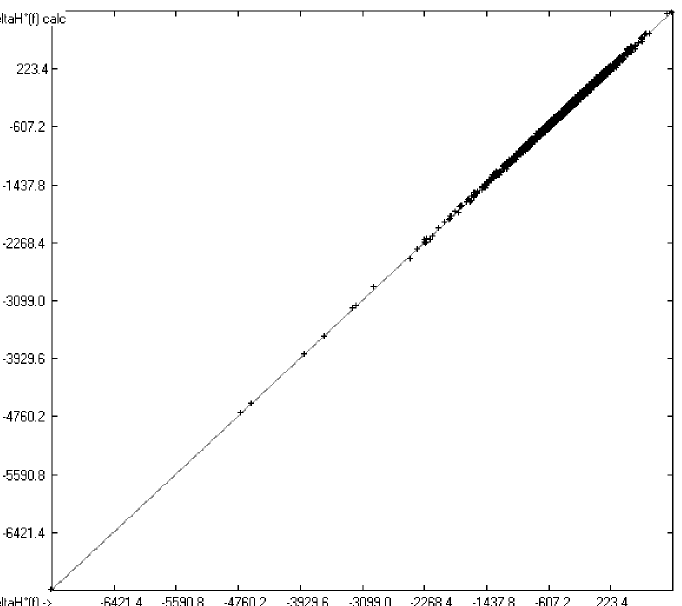
Figure 3. Correlation diagram of the heat of formation (in kJ/mol), (N = 4886, R 2 = 0.9979, regression line: intercept = − 0.5539; slope = 0.9979).